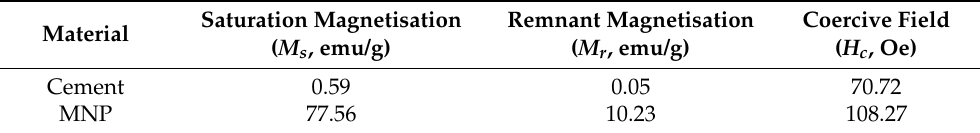
Figure 2. Magnetisation curves of ( left ) Portland cement, ( right ) MNPs. Table 2. Magnetic properties of cement and Fe3O4 nanoparticles (MNP) used in the